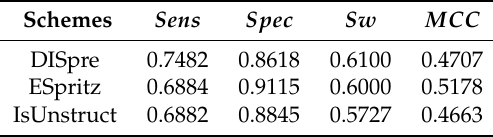
Table 9. Performance comparison with existing schemes on R80